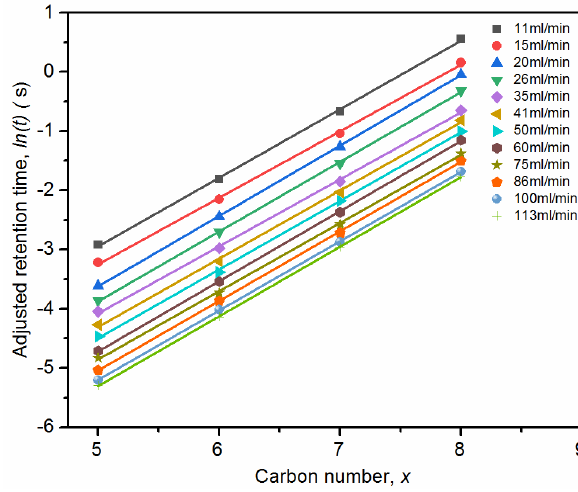
Figure 5: Adjustment retention time of probe molecules for